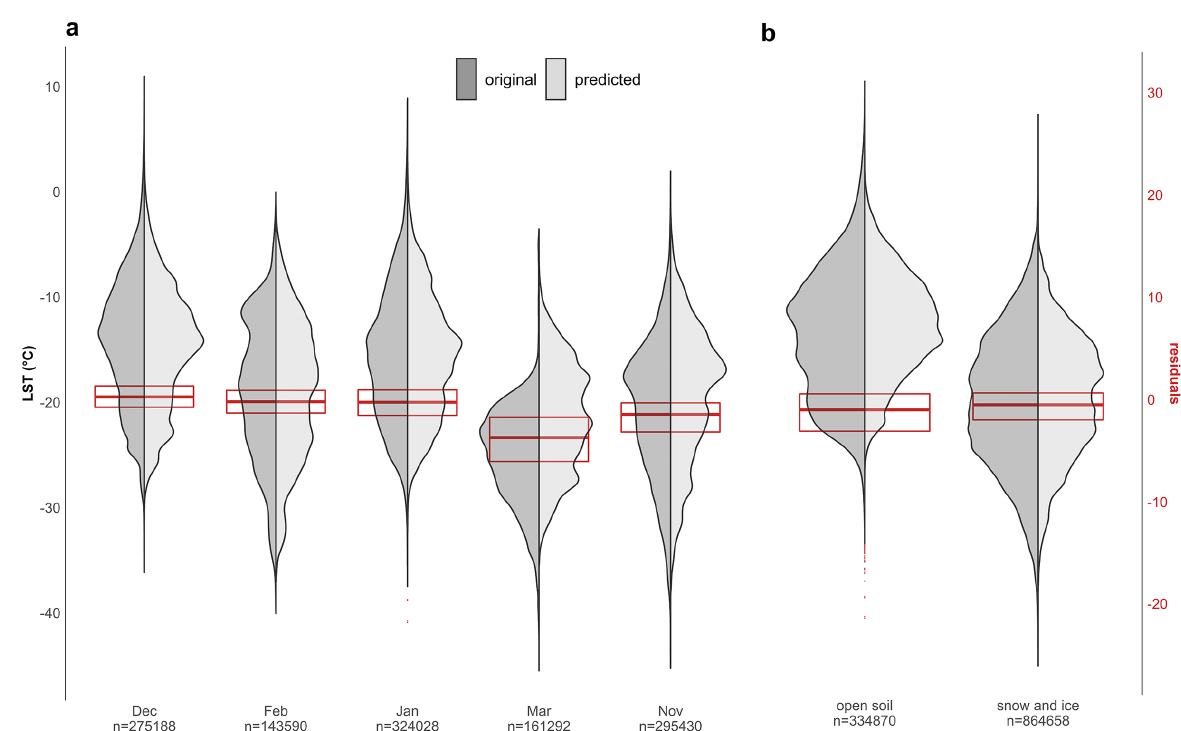
Figure 8. Observed and predicted LST in dark and light grey violin plots for all training and validation samples. Residuals (observed-predicted LST values) in red boxplots ( a ) by month and ( b ) by land cover